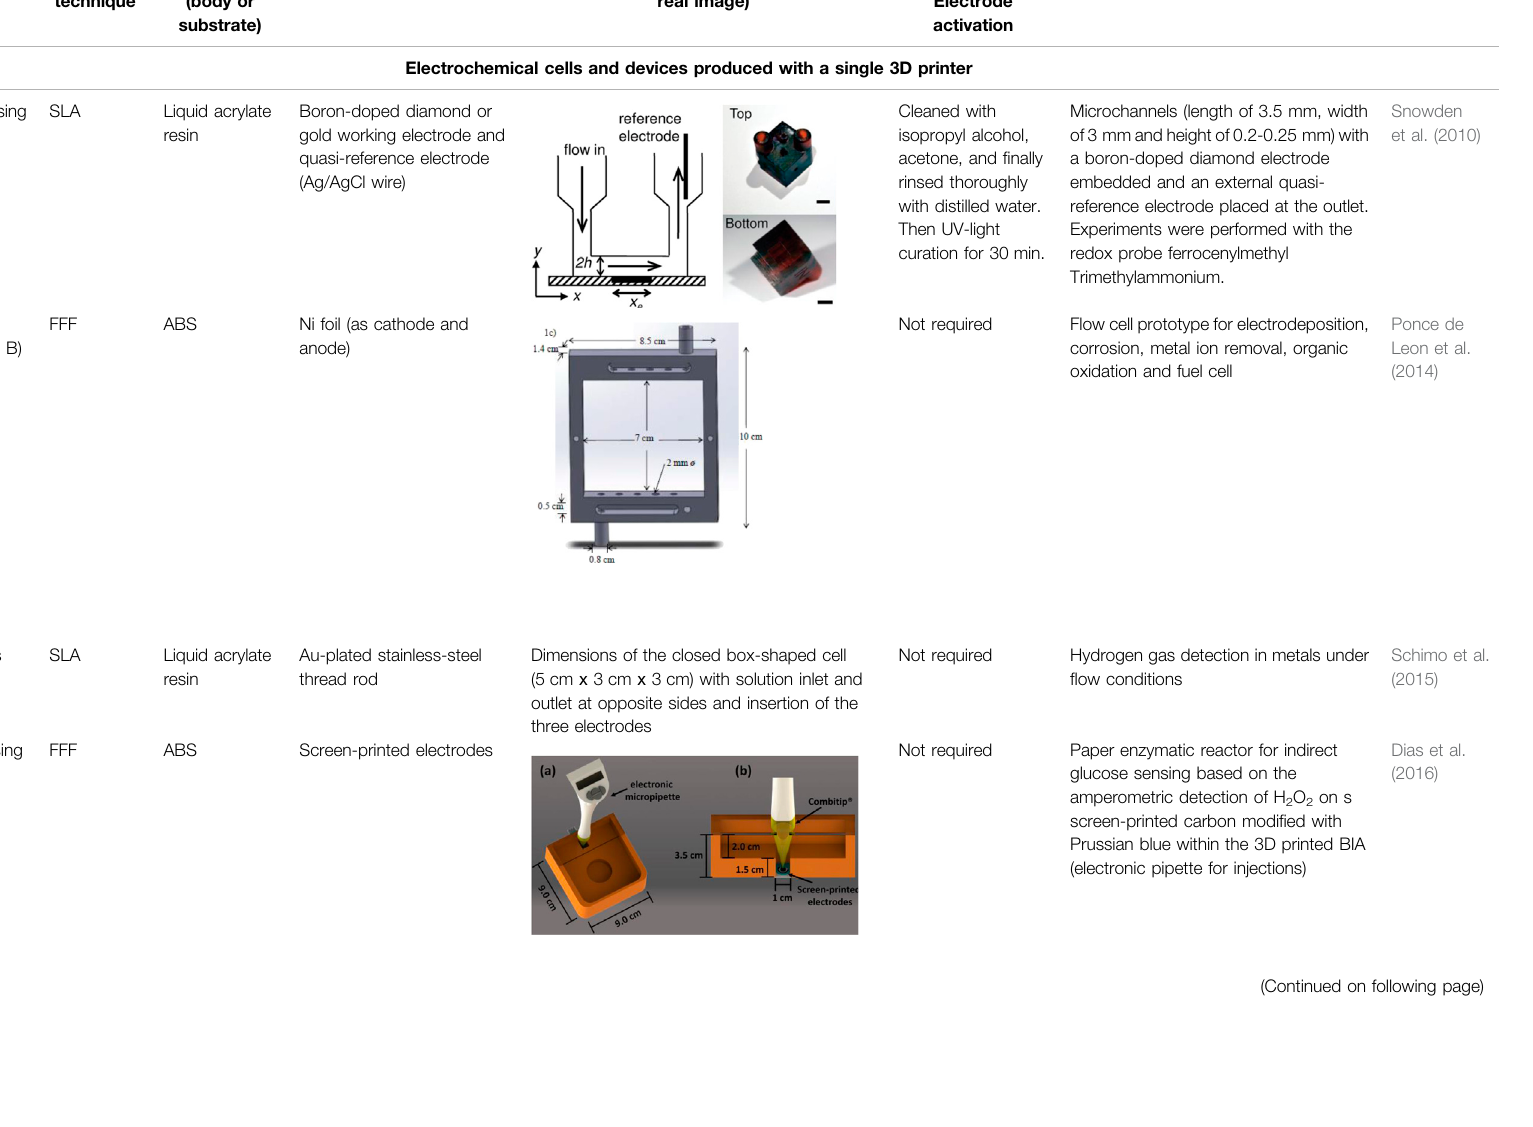
TABLE 2 | - 3D printed electrochemical cells, including micro fl uidic devices and wearable platforms, their respective printing technique, polymers, and applications. Electrochemical